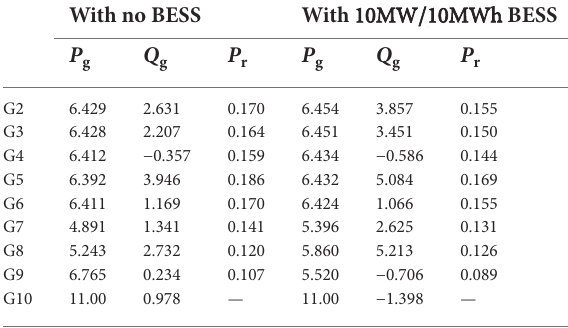
TABLE 6 Generation power dispatchand primary reserve in per unit.